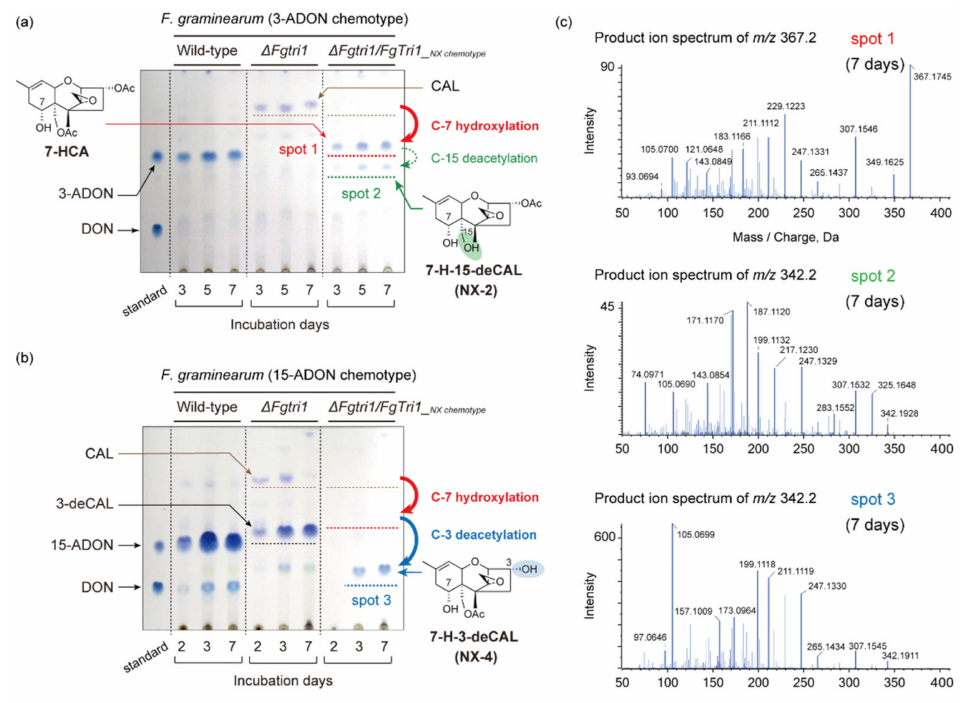
Figure 2. Trichothecene profiles of transgenic 3-ADON and 15-ADON chemotype strains, in which FgTri1 was replaced with FgTri1_ NX chemotype ( F. graminearum ∆ Fgtri1/FgTri1_ NX chemotype ). ( a ) Time course of trichothecene accumulation of the ∆ Fgtri1 and ∆ Fgtri1 / FgTri1_ NX chemotype mutants of the 3-ADON chemotype visualized by TLC using the 4-(4-nitrobenzyl)pyridine (NBP)/tetraethylene pentamine (TEPA) method [12]. ( b ) Time course that is essentially the same as ( a ), but of mutants of the 15-ADON chemotype. The toxin profiles of each chemotype (wild-type) are also shown for comparison. The structures were confirmed by LC-MS/MS analysis ( c ). MS/MS spectra of trichothecenes included in TLC spots 1, 2, and 3 (red, green, and blue dotted lines). The spectra of m / z 367.2, m / z 342.2, and m / z 342.2, which correspond to [7-HCA + H] + ( m / z 367.1751), [7-H- 15-deCAL (NX-2) + NH 4 ] + ( m / z 342.1911), and [7-H-3-deCAL (NX-4) + NH 4 ] + ( m / z 342.1911), are shown. Dense blue spots on the lanes of the ∆ Fgtri1 mutant include 3-deacetylcalonectrin (3-deCAL), a shunt metabolite of CAL